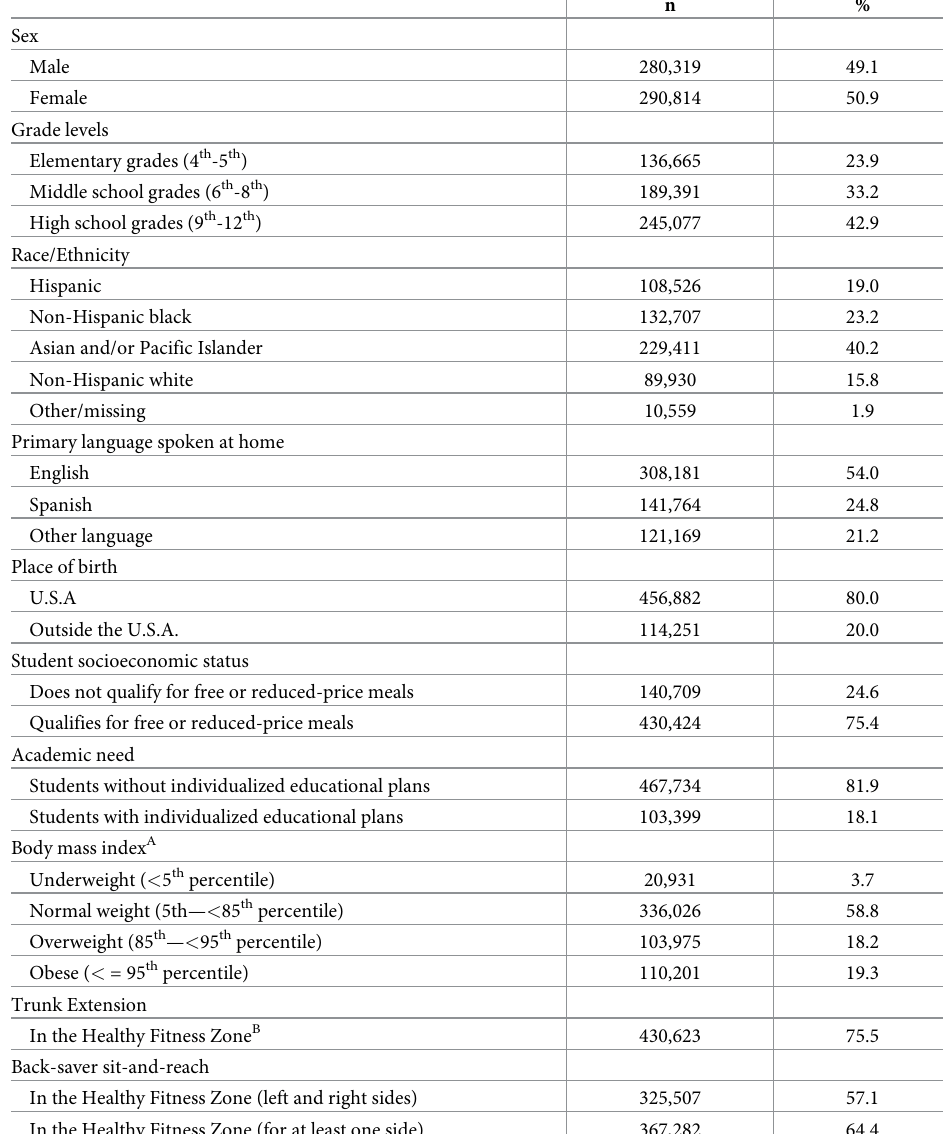
Table 1. Demographic characteristics of New York City public school 4 th -12 th grade students with FITNESS- GRAM 1 data (N = 571,133),